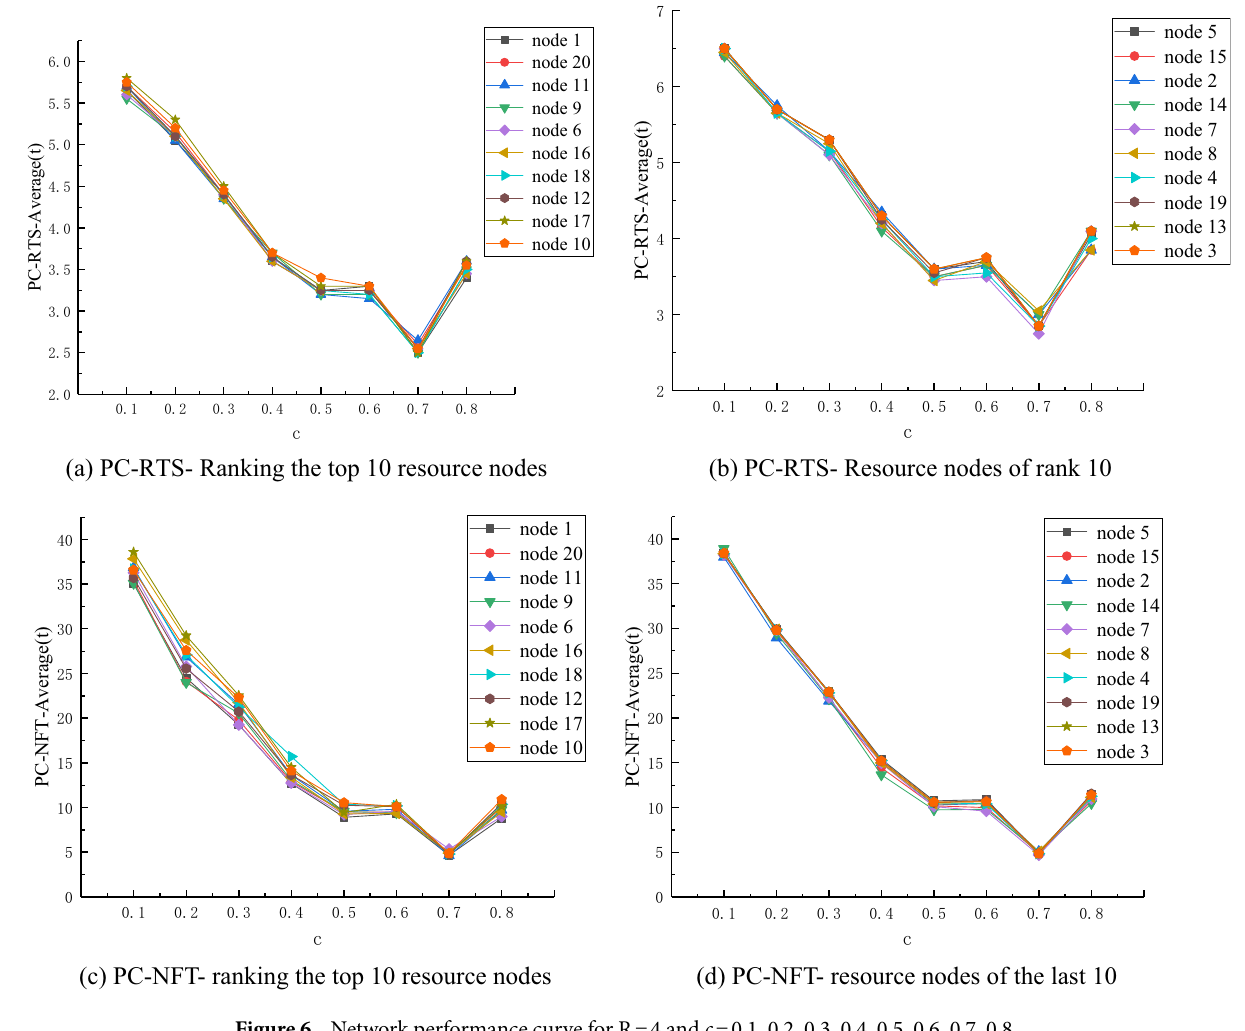
(c) PC-NFT- ranking the top 10 resource nodes (d) PC-NFT- resource nodes of the last 10 Figure 6. Network performance curve for R = 4 and c = 0.1, 0.2, 0.3, 0.4, 0.5, 0.6, 0.7,